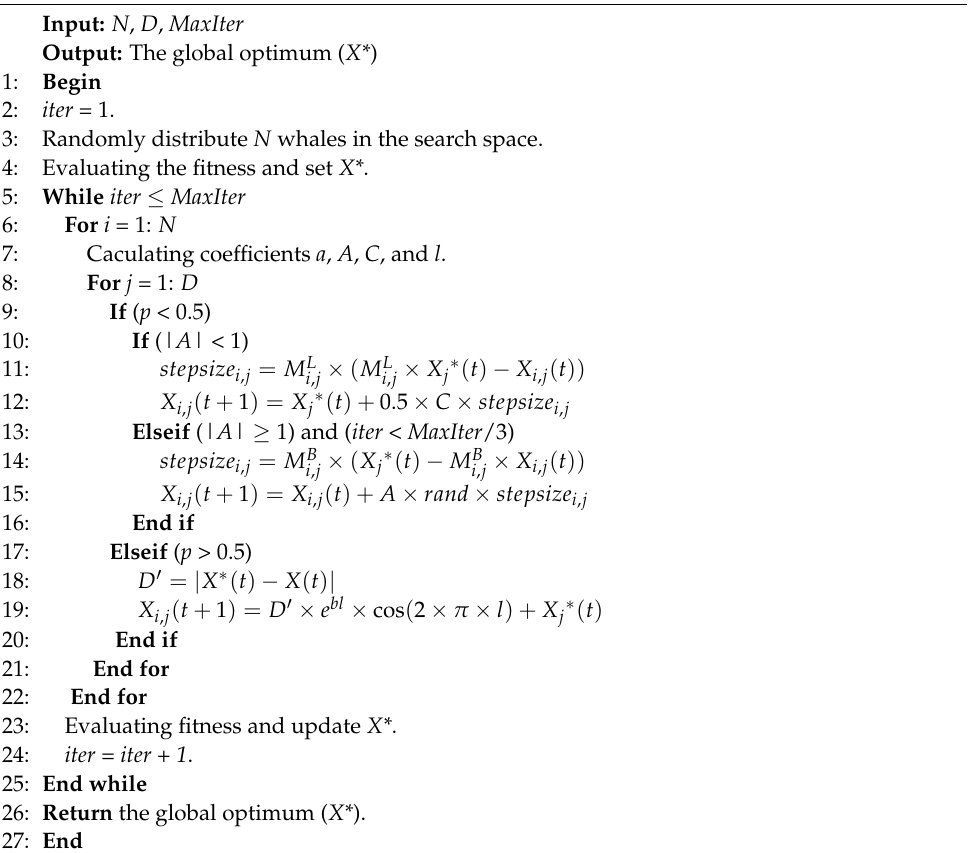
Algorithm 1 The EWOA-OPF